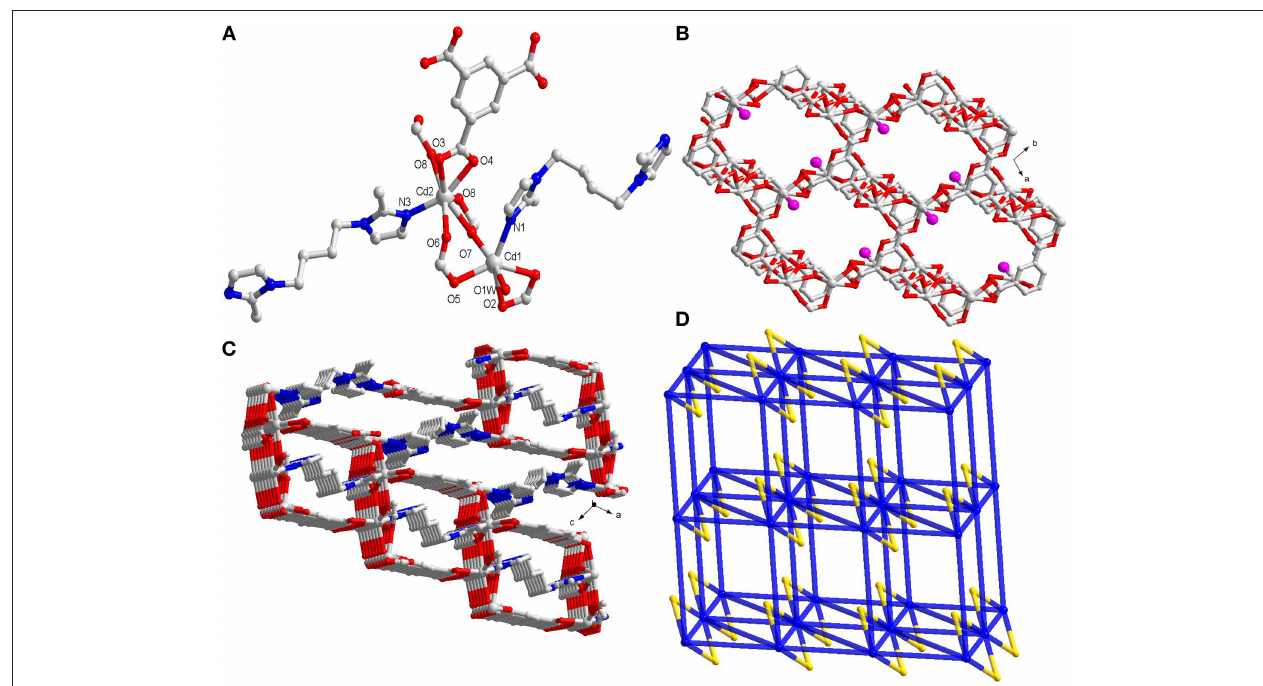
FIGURE 1 | (A) The coordination environment around Cd(II) centers in 1 ; (B) Perspective view of 2D layer constructed by Cd(II) centers and btc linkers(the pink ball represents the uncoordinated carboxylate group); (C) The 3D framework connected by btc and bib ligands; (D) Schematic representation of the 3D 10-connected network(the yellow ball represents the formate linker).